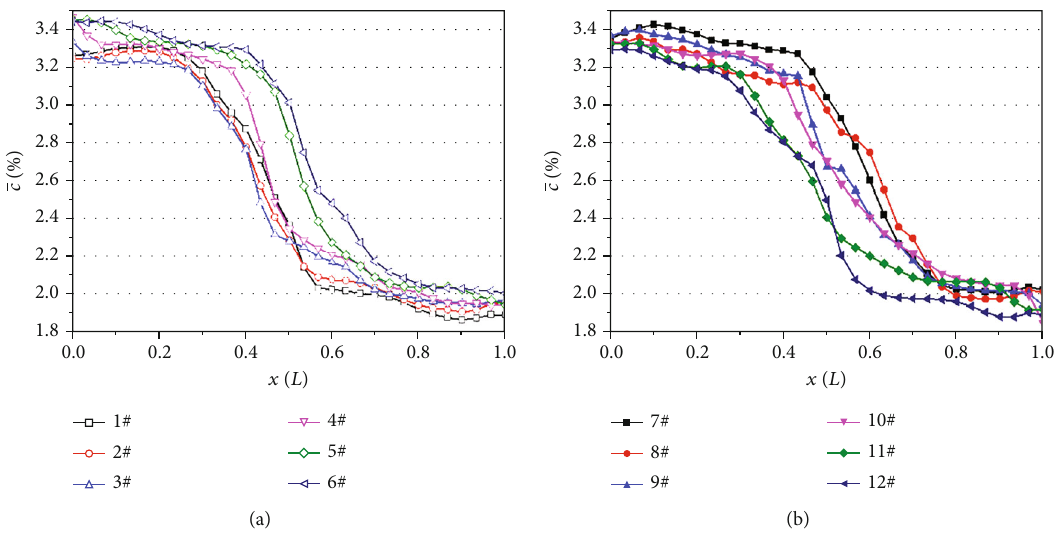
Figure 15: Variation of average salinity of the duct cross-section in RERD.